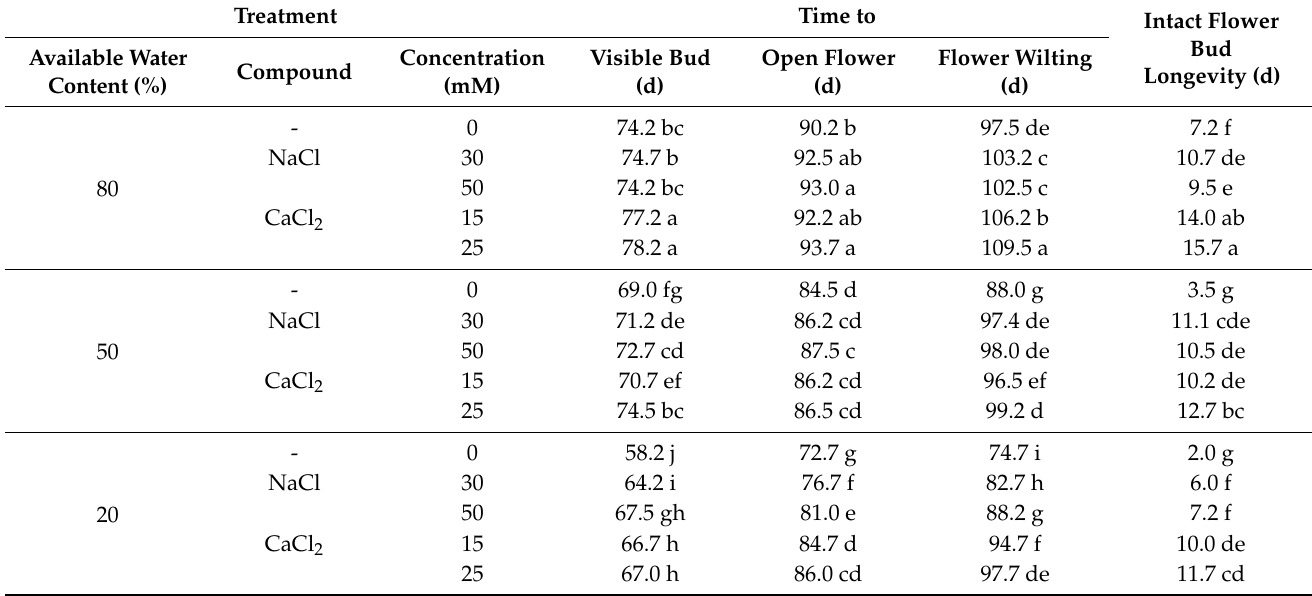
Table 1. Time to flowering (also referred as time to visible bud), time to open flower, time to wilting (i.e., petal turgor loss) and intact (on plant) flower bud longevity [(time to wilting)—(time to open flower)] of periwinkle cv. ‘Pacifica XP Really Red’ plants initially receiving NaCl (0, 30 and 50 mM) or CaCl 2 (15 and 25 mM) via irrigation (five applications at 3 d intervals), and subsequently exposed to different watering levels (80, 50 and 20% available water content) during cultivation. At first application, plants were at the four-leaf stage. Means followed by different letters indicate significant differences ( p = 0.05; comparison in columns). Values are the mean of four